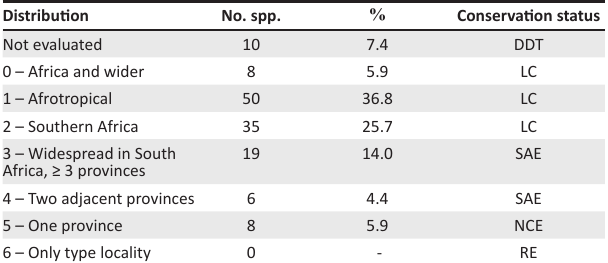
TABLE 3: Level of endemicity of the 136 spider species sampled at the Tswalu Kalahari Reserve.